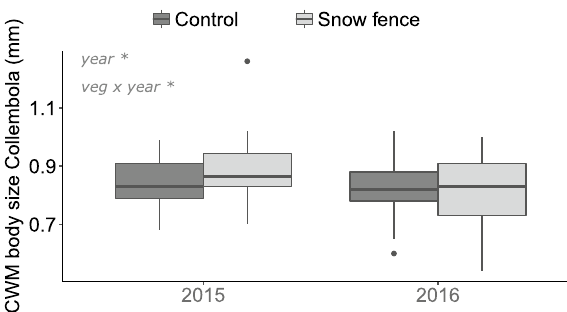
Figure 6. Community weighted means of Collembola body sizes averaged over vegetation types in unmanipulated, ambient (Control) plots and increased snow depth (Snow fence) plots (n = 11). *P < 0.05, **P < 0.01, error bars are standard deviations. Boxes indicate 50% of the central data, the black thick line being the median, black dots are outliers (further than 1.5 times the Box’s range above or below its